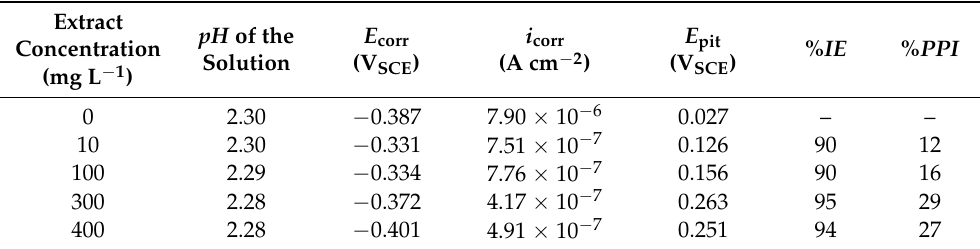
Table 2. Corrosion parameters of 304 stainless steel in hydrochloric acid solution with and without the addition of Terminalia bellirica fruit extract. Extract